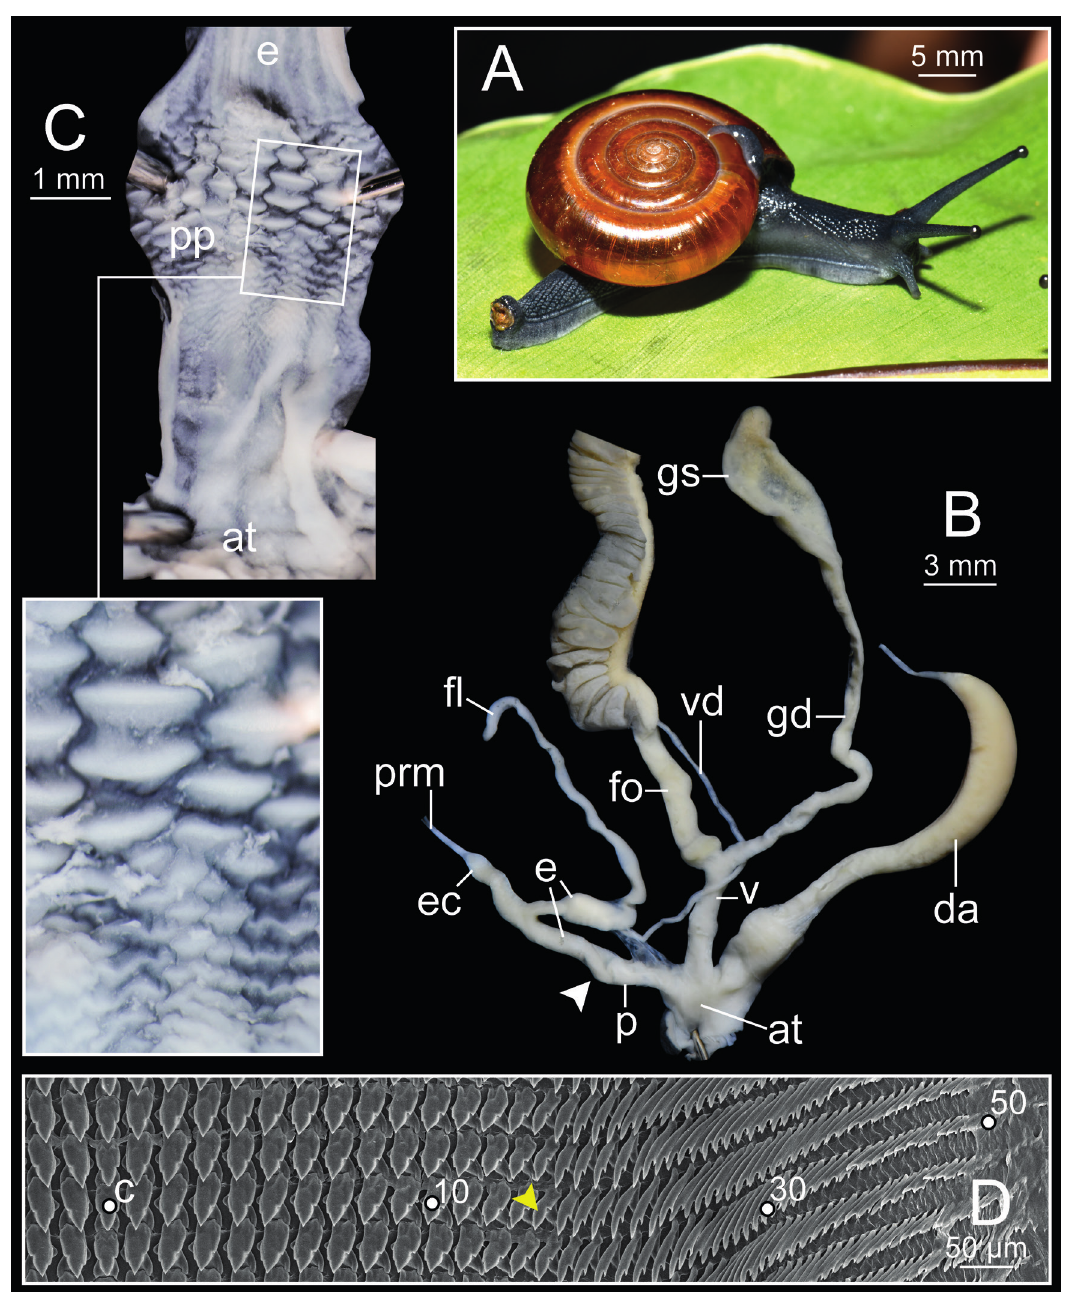
Fig. 5. Sarika khmeriana Pholyotha & Panha sp. nov., paratype (CUMZ 7905). A . Living snail. B . Beneral view of genital system. C . Internal structure of penis. D . Representative SEM image of the radula. Central tooth indicated by ‘C’; yellow arrow heads indicate lateral teeth with the transition to marginal teeth; white arrow heads indicate the end of